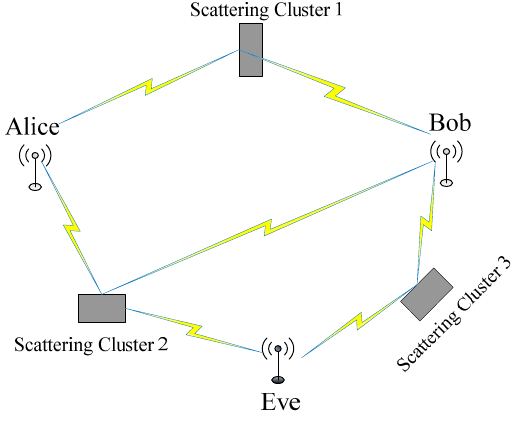
Figure 1. Wireless communication scenario.